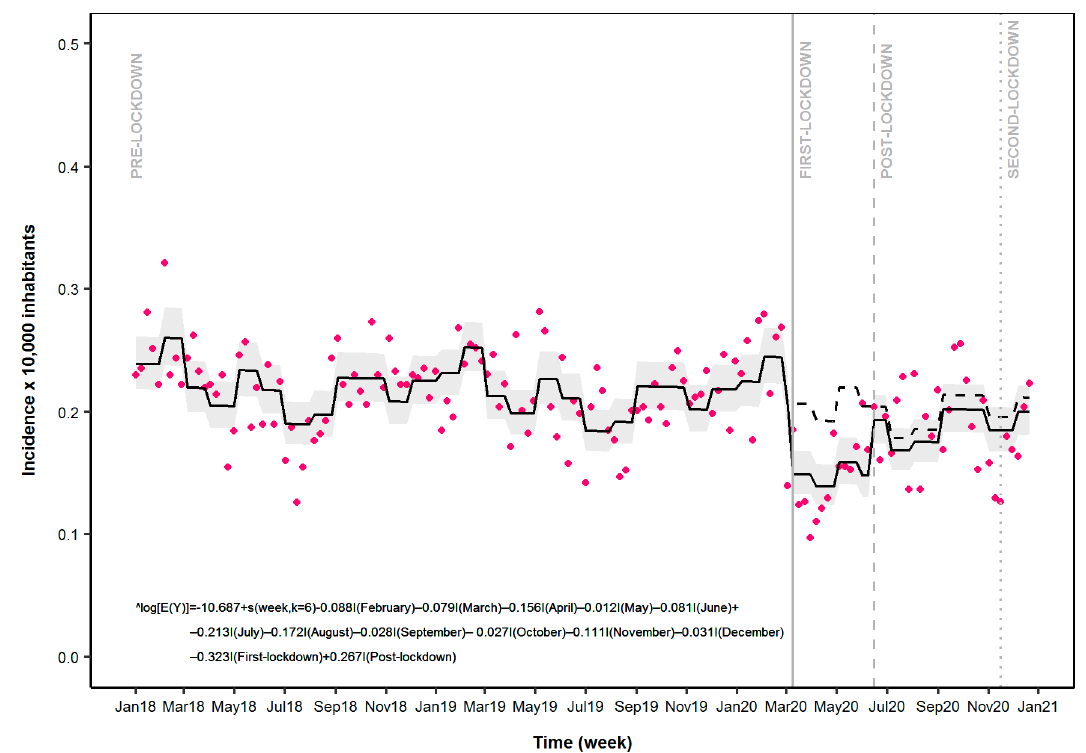
Figure 2. Time series analysis of emergency department access across different periods: Pre-Lockdown, First Lockdown, Post-Lockdown and Second Lockdown. Legend: Magenta dots: estimated incidence of Emergency department access; solid line: predicted model based on estimated outcome; Grey zone: 95%CI of the predicted model; Dashed line: expected scenario in the absence of LMI.